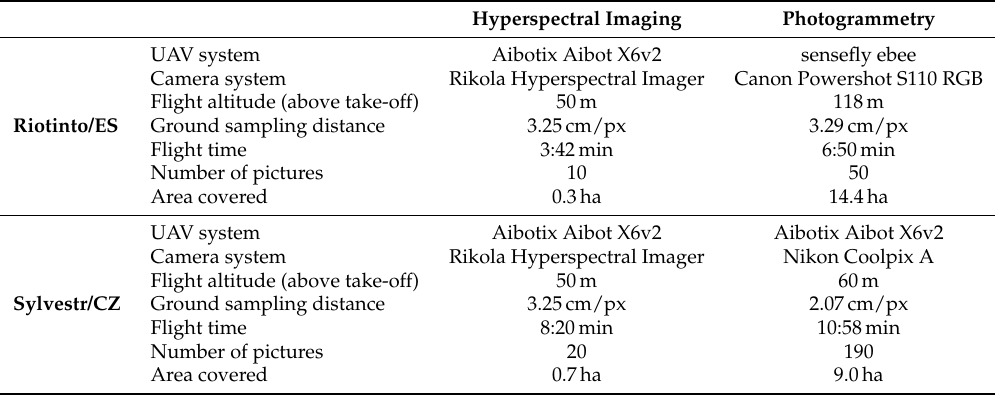
Table 1. Flight setup for the surveys performed at Riotinto area/Spain (ES) and Sylvestr mine/Czech Republic (CZ) . Flight altitude is given in meters above take-off location. Furthermore, note that the ground sampling distance is given for the respective flight altitude, but is varying due to